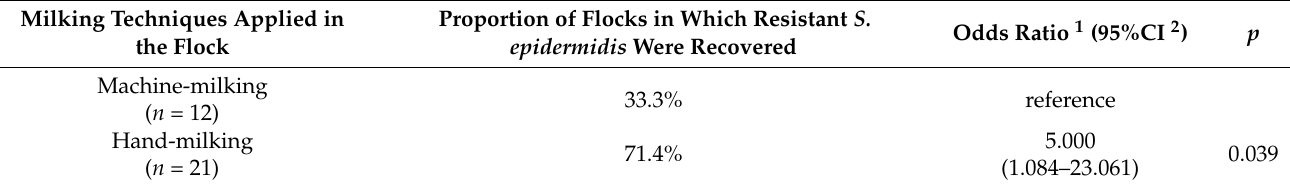
Table 5. Results of multivariable analysis for the presence of resistance to antimicrobial agents in S. epidermidis isolates from cases of subclinical mastitis in sheep in